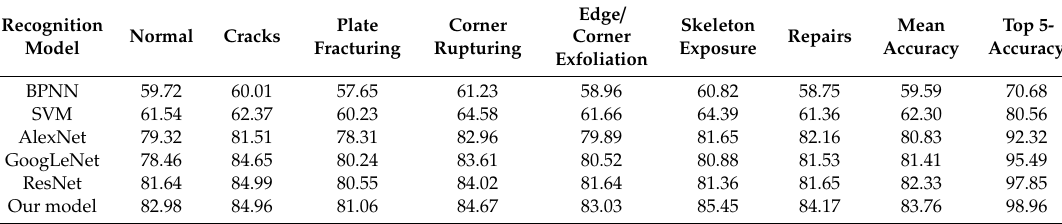
Table 1. Comparison of the six models on surface defect